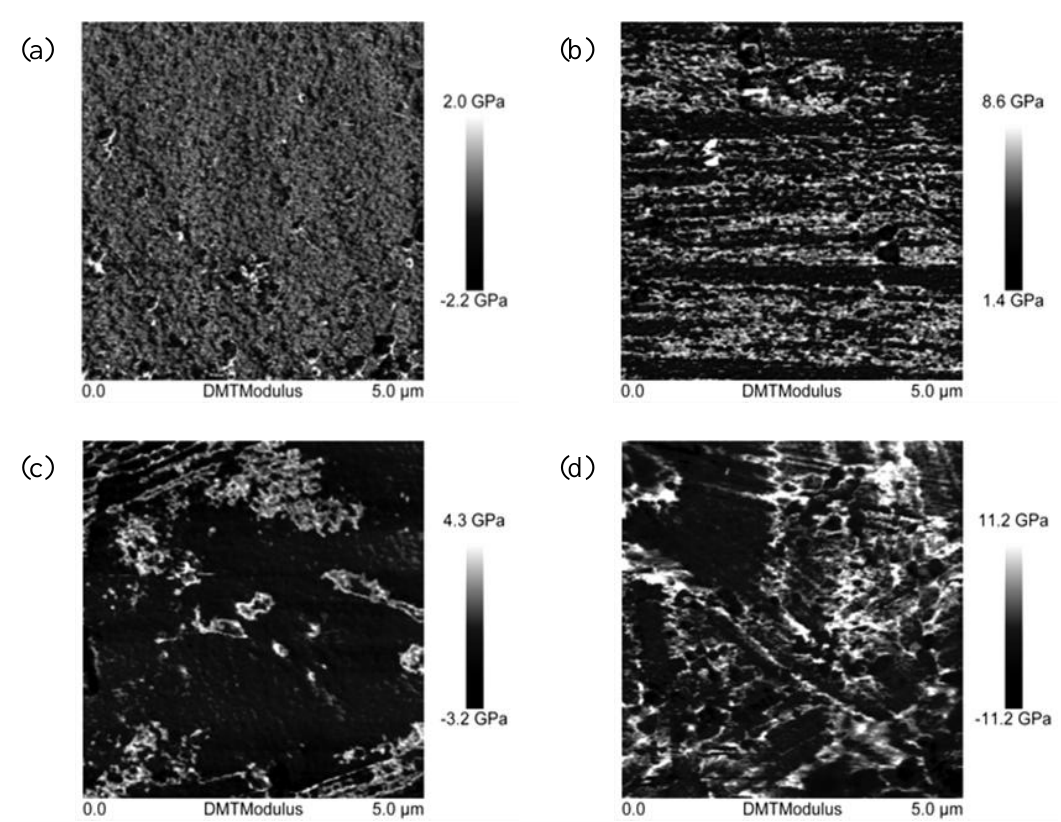
Figure 17. AFM images obtained by QNM for the surface of samples of unfilled EP ( a ) and for composites: ( b ) EPBP1-3.0; ( c ) EPIHSP3-3.0; ( d )